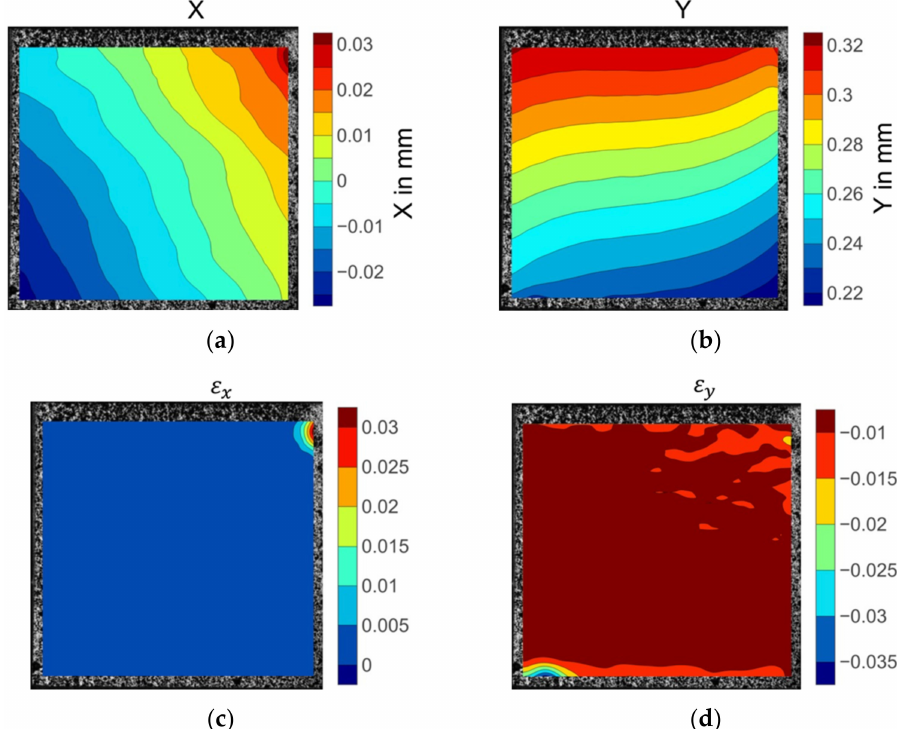
Figure 8. The displacement and strain field contour plots of the 0 ◦ axial compression specimen: ( a ) Displacement in the X direction; ( b ) displacement in the Y direction; ( c ) strain in the X direction; ( d ) strain in the Y